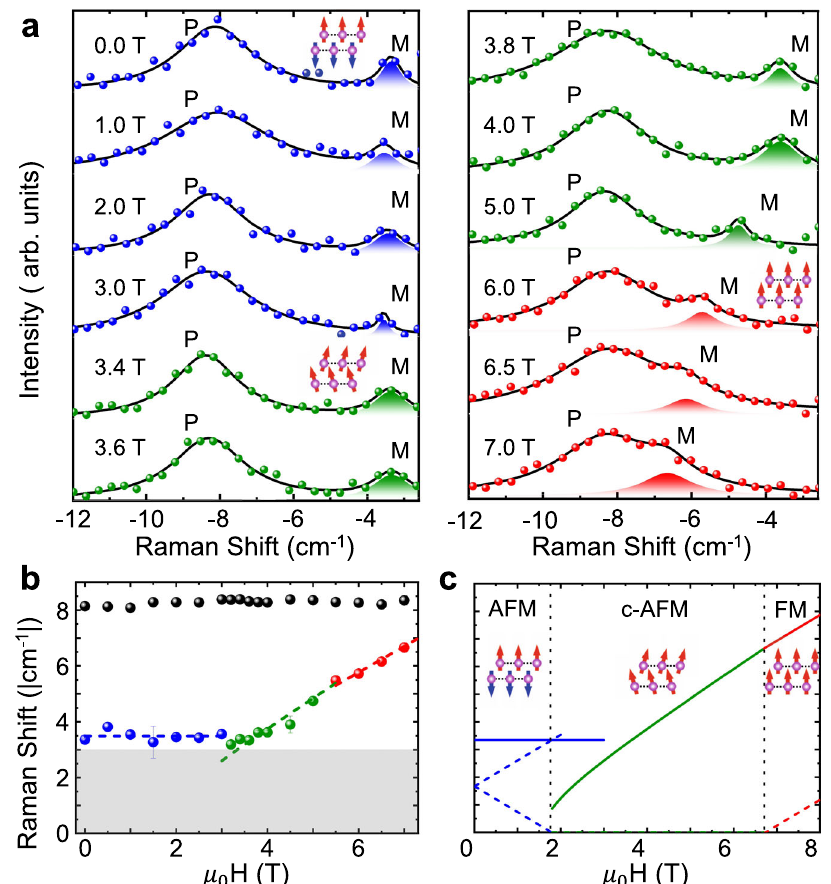
Fig. 3 Magnetic- fi eld-dependent Raman spectra of the magnon mode from the 2-SL with co-circular σ + / σ + polarization. a Raman spectra at 12 K as a function of B - fi eld. Black solid line is fi tting with the sum of two Lorentzian functions. P and M represent phonon and magnon, respectively. b Extracted central frequency for both the phonon and magnon vs. B fi eld. Error bars displayed are smaller than the data points. c Calculated magnon modes in the antiferromagnetic (AFM), canted-AFM (c-AFM), and ferromagnetic (FM)